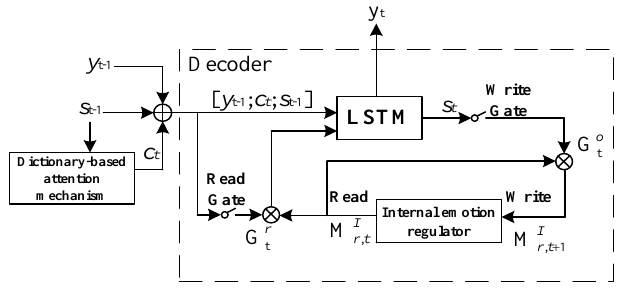
Figure 3. Internal Emotion Regulator.